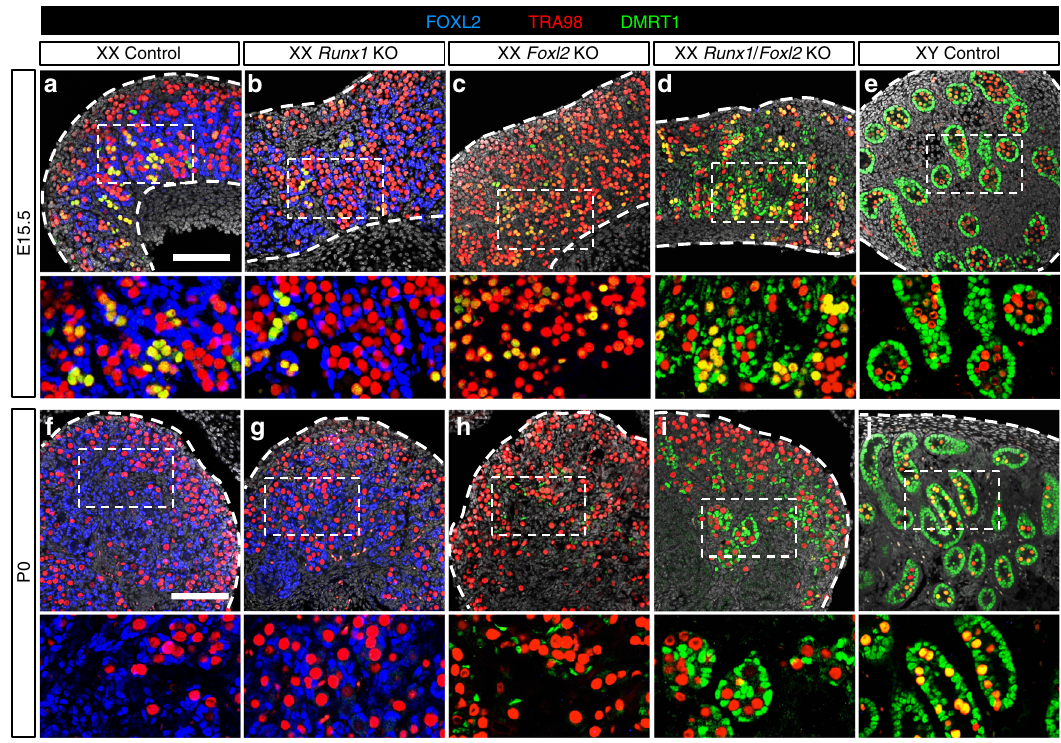
Fig. 5 Combined loss of Runx1 and Foxl2 masculinizes the fetal ovaries. a – j Immuno fl uorescence for Sertoli cell and germ-cell marker DMRT1, germ-cell marker TRA98, and granulosa cell marker FOXL2 in XX control, XX Runx1 KO, XX Foxl2 KO, XX Runx1/Foxl2 double knockout, and XY control gonads at E15.5 ( a – e ) and at birth ( f – j ). Controls correspond to wild-type littermates. The gray represents DAPI nuclear staining. Dotted lines outline the gonads. Higher magni fi cations are shown for the outlined boxes in a – e and f – j , respectively. Scale bars: 100 µ m. At least three independent biological replicates were analyzed and the images presented are representative of all replicates. Single-channel images are provided in Supplementary Figs. 3 and